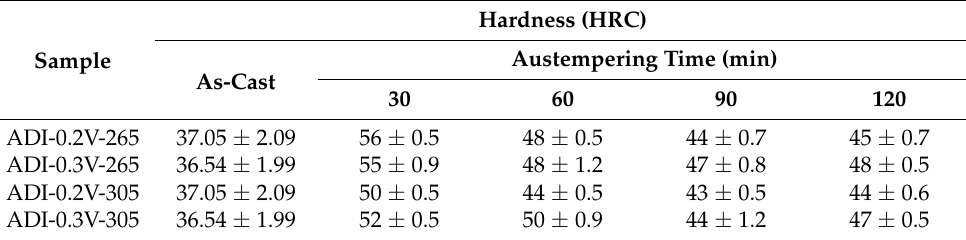
Table 6. Hardness Rockwell C as a function of the austempering